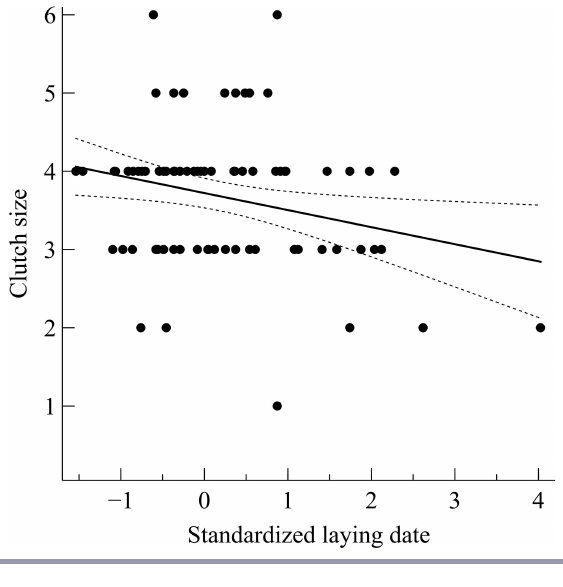
Fig. 2 . Clutch sizes (black dots) of Turquoise-fronted Parrot ( Amazona aestiva ) nests as a linear function (solid line) of the time of breeding (standardized laying date) during the breeding seasons 2003, 2004, 2005, and 2006 at Loro Hablador Provincial Park in northern Argentina. Dotted lines represent the 95% confidence interval.